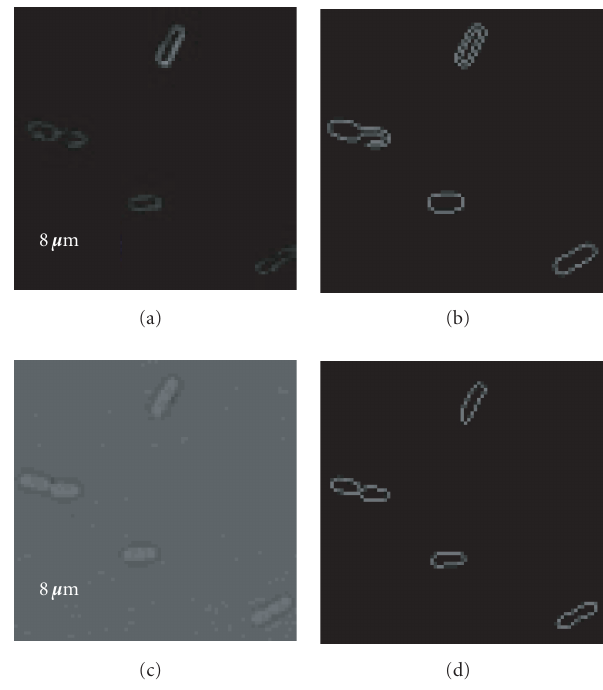
Figure 6: Comparison of edge detection from images of E. coli cells stained with a membrane dye and from DIC images. (a) E. coli cell membranes stained with FM5-95. (b) Results of edge detection us- ing the image in (a). (c) DIC image of E. coli cells. (d) Results of edge detection using the image in